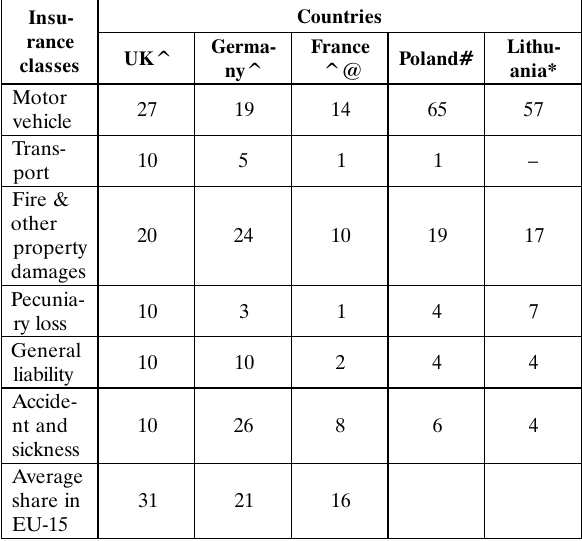
Table 10. Structure of premiums in selected classes of non-life insurance, Poland, Lithuania and selected countries of EU-15, in percentage